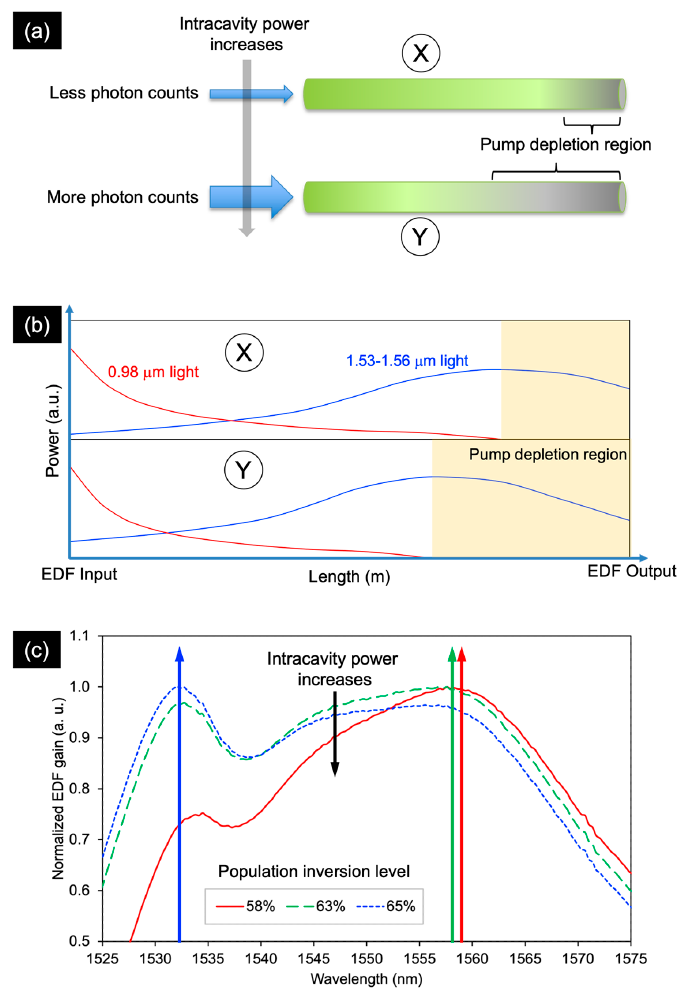
Figure 8. ( a ) Schematic diagram of light propagation in the EDF with variation of intracavity powers, ( b ) pump and signal light propagation profile in the EDF and ( c ) the normalized EDF gain with different population inversion levels. X and Y represent the condition of high and low output coupling ratios, respectively.